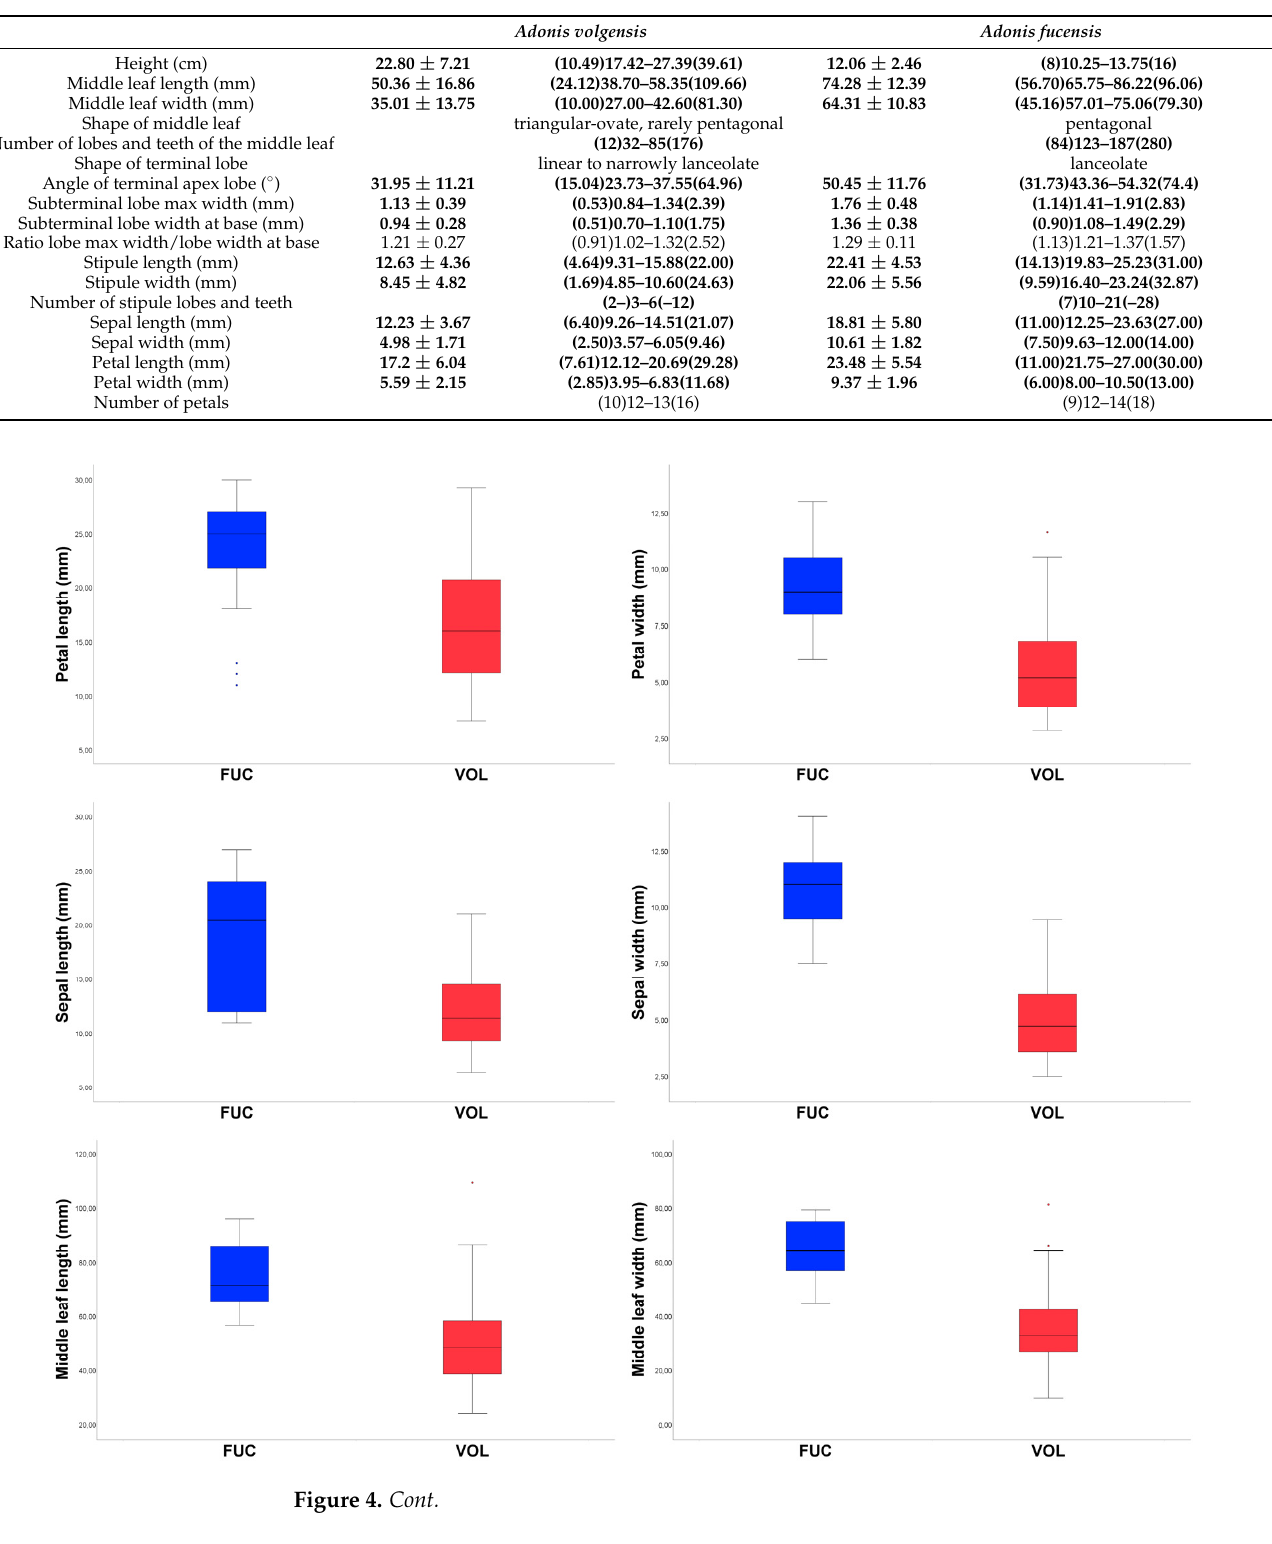
Table 2. Morphological comparison of A. volgensis and A. fucensis . Quantitative continuous characters are expressed in mm and are reported as mean ± standard deviation and 25–75 percentiles (extreme values in brackets). For quantitative discrete cardinal characters, 25–75 percentiles are given (extreme values in brackets). Significantly different character states are shown in bold ( p < 0.01).